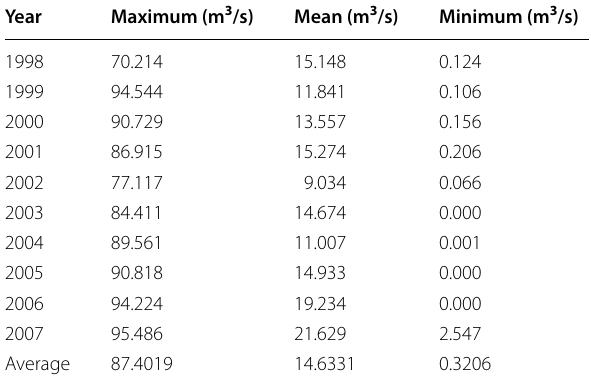
Table 3 Rib annual maximum, mean and minimum flow